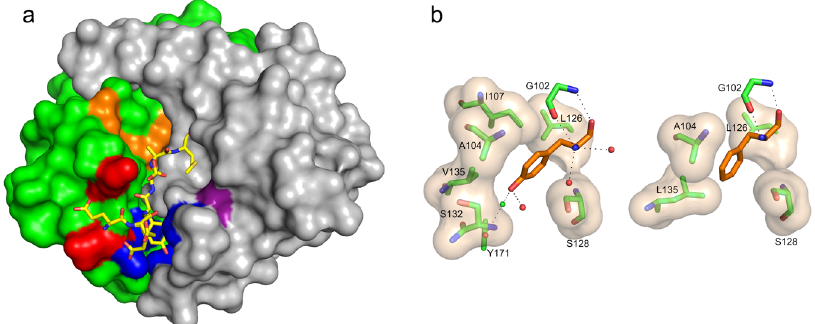
Fig. 5 Engineering a protease directed against active RAS. a Surface representation of RASProtease(I) with substrate binding sites colored purple (S1), orange (S2 and catalytic residues), red (S3), and blue (S4) with the bound YSAM peptide overlaid. b Interactions at the P4 site of RASProtease(I) (left) and its progenitor Protease1(N) (right). The van der Waals interactions between residues in the protease active site (carbons colored green) and the bound P4 residue (carbons colored orange) are represented as a tan surface. Hydrogen bonds are represented as black dashed